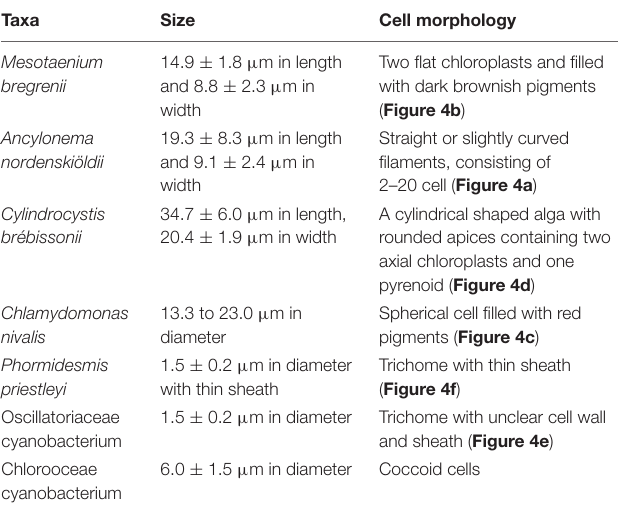
TABLE 2 | Taxa of phototrophs observed with a microscope on the Svalbard glaciers.